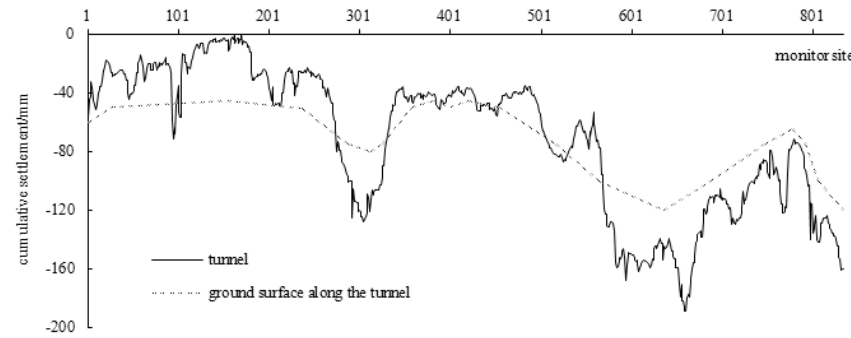
Figure 6. Graph of tunnel settlement and land subsidence along A from 1995 to 2000.